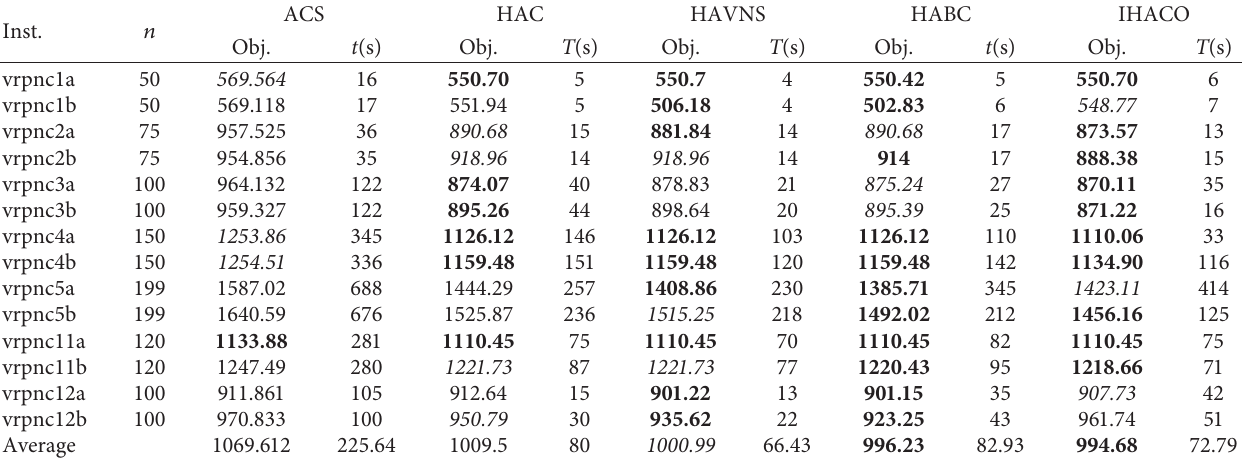
Table 2: Comparison results of IHACO and four algorithms.